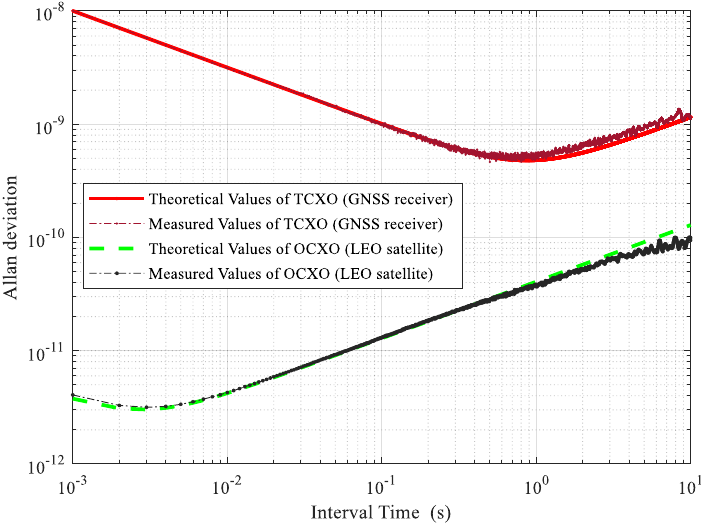
Figure 6. Theoretical and measured clock Allan variances.